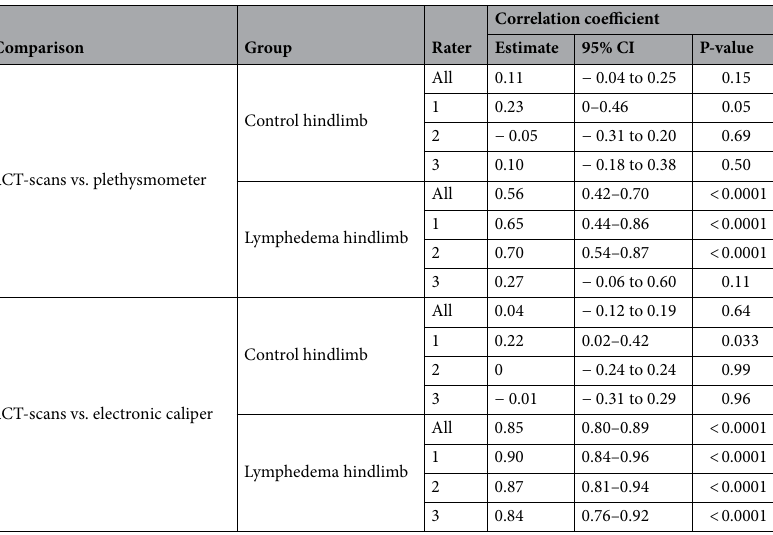
Table 4. Correlation coefficients with 95% CIs for plethysmometer and electronic caliper vs µCT-scans. CT computed tomography, μ